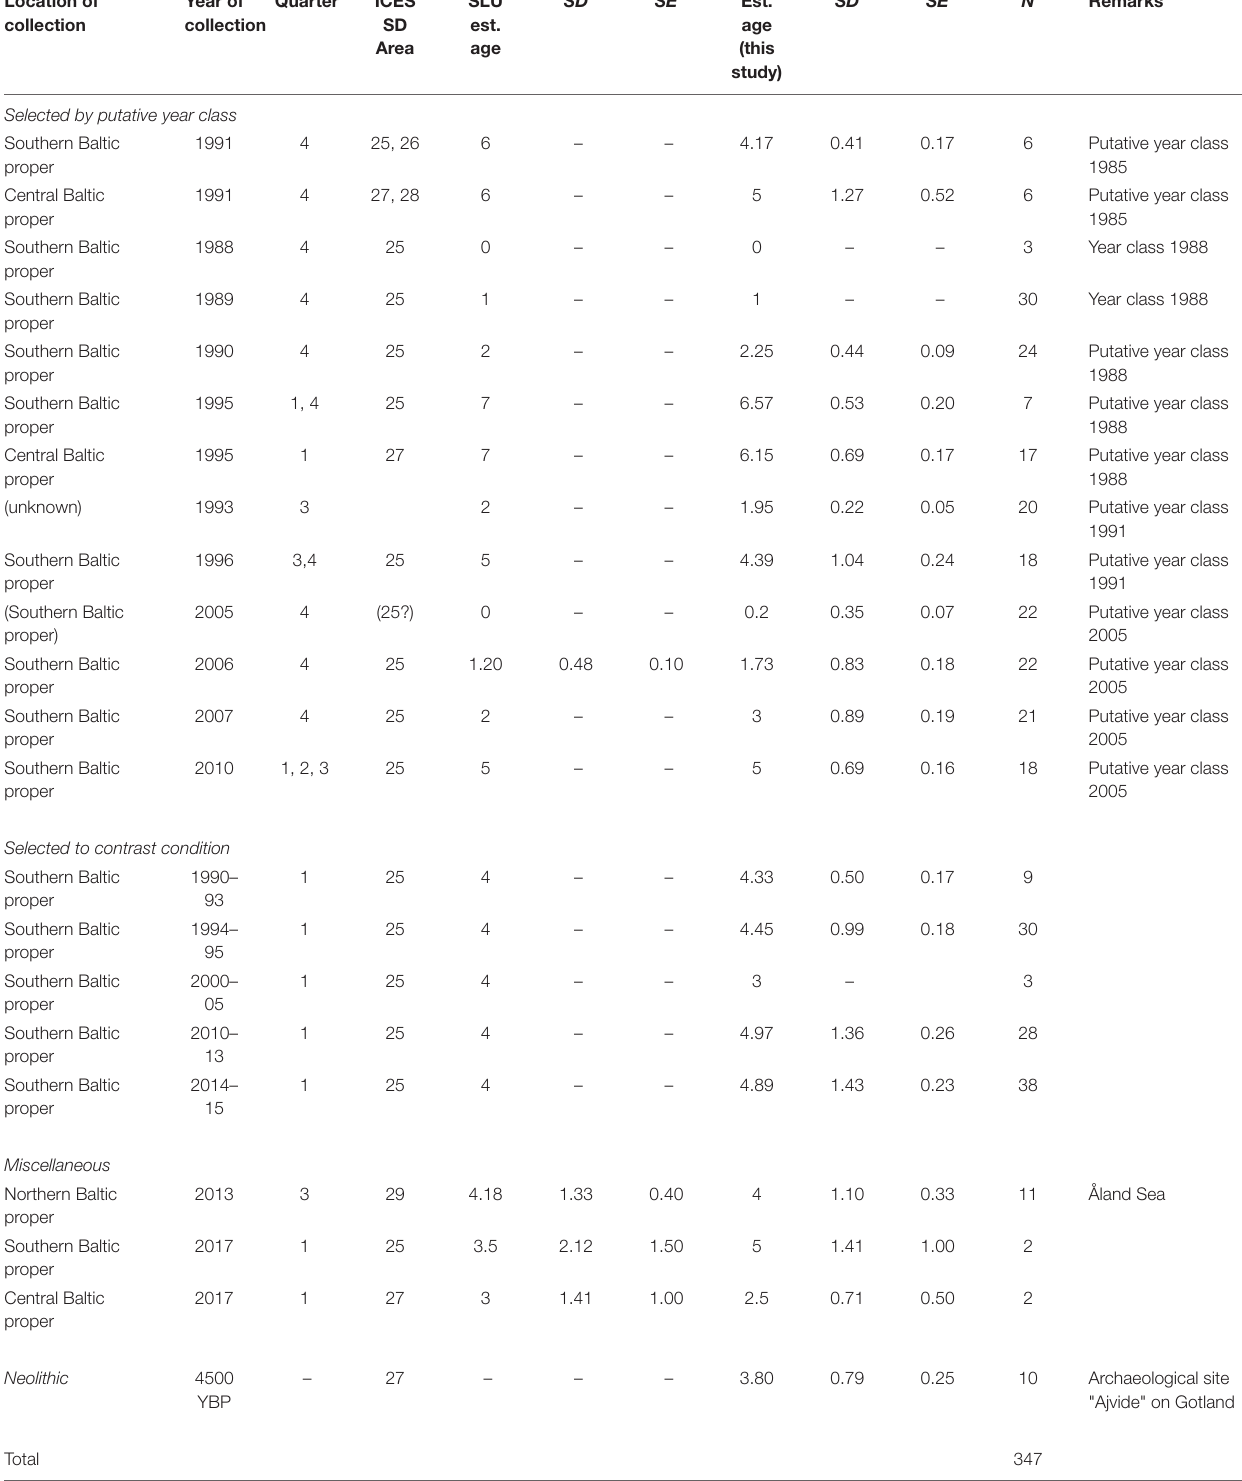
TABLE 1 | Otolith samples used in this